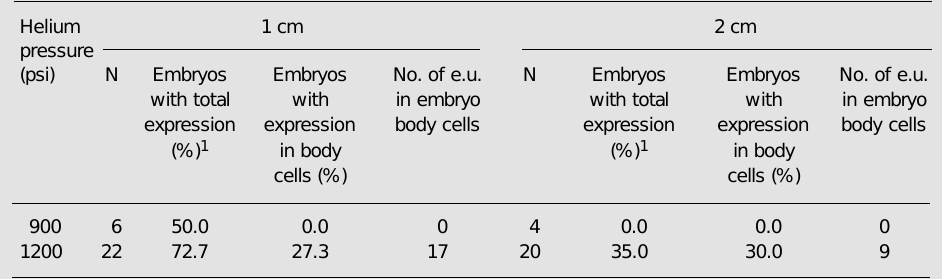
1 Embryos with ß-gal expression in body cells or extra-embryonic tissue or both. DNA-coated microparticle flying distance to the embryo was 11 cm. e.u. = expression